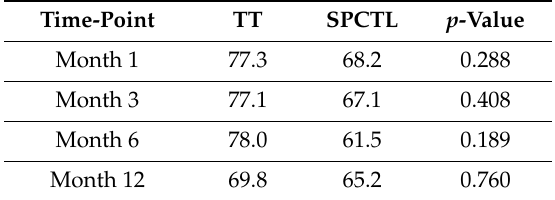
Table 4. Mean Adherence to protocol by group and timepoint.